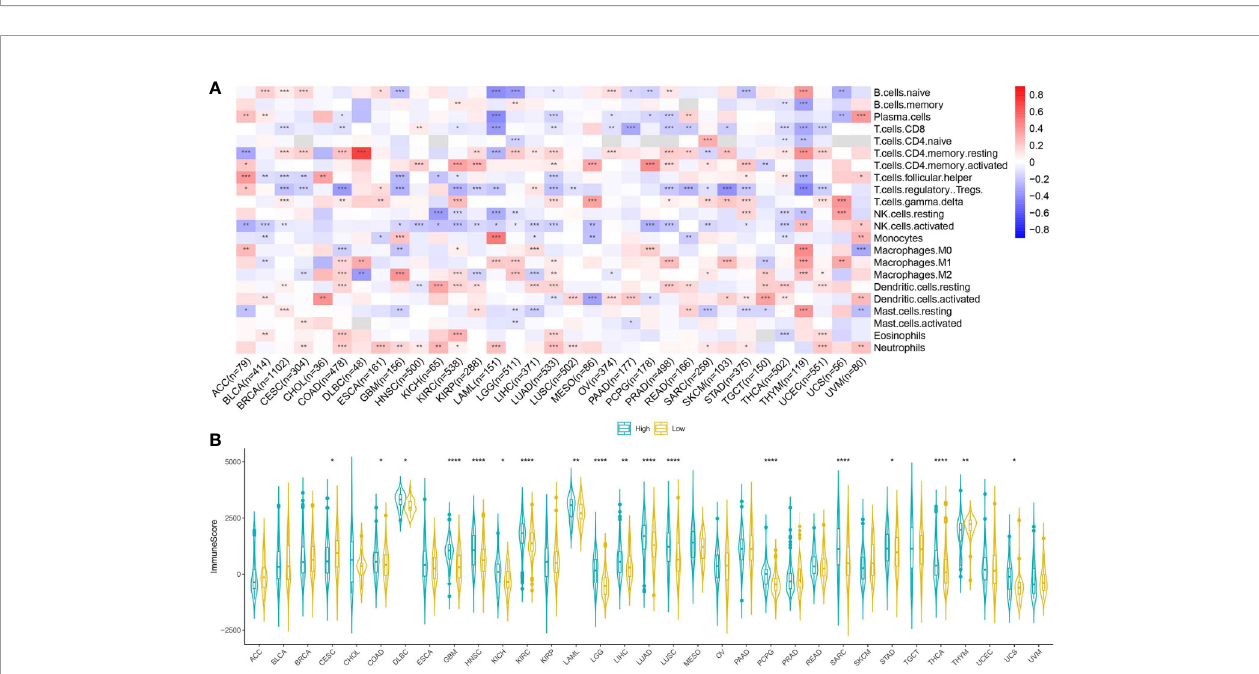
FIGURE 5 | Relationship between CMTM6 expression and tumor microenvironment factors. (A) Correlation of CMTM6 expression with immune in fi ltrate subtypes across 33 cancer types. Red color represents positive correlation and blue color represents negative correlation. (B) Correlation of CMTM6 expression and immune scores of 33 different cancer types. *p < 0.05; **p < 0.01, ***p < 0.001, ****p <